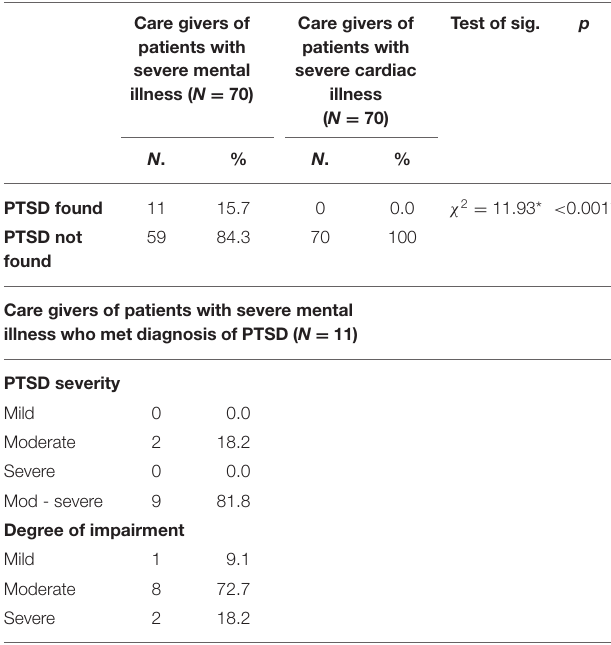
TABLE 4 | Posttraumatic diagnostic scale (PDS) in both care givers of patients with cardiac illness (ischemic cardiac disease complicated with chronic heart failure).